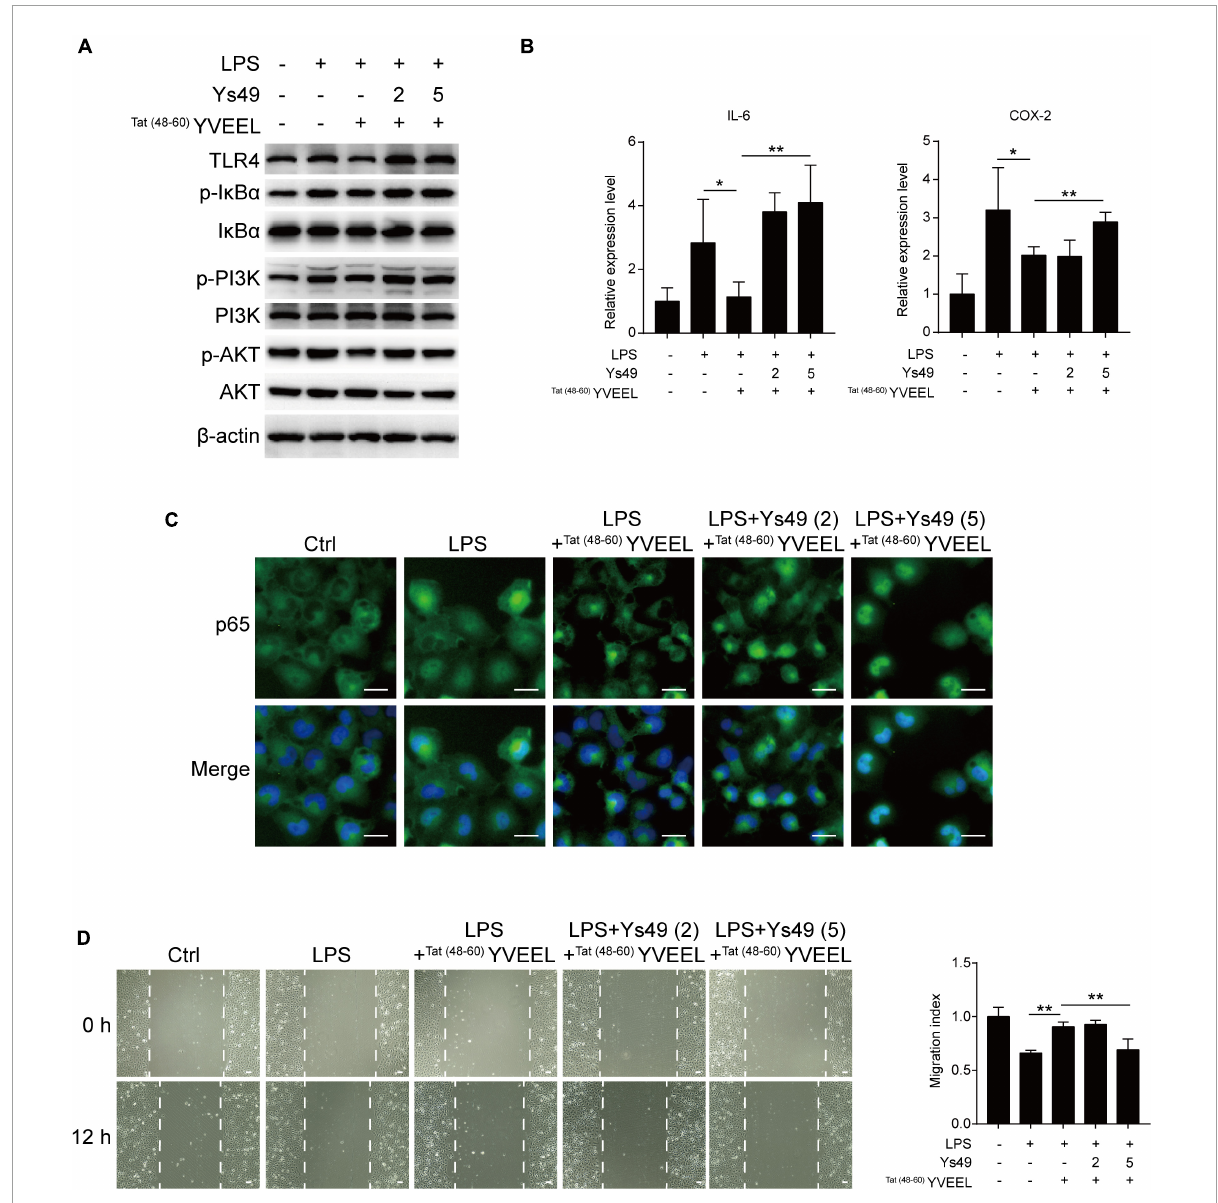
FIGURE4 Tat ( 48 - 60 ) YVEEL attenuates TLR4-mediated signaling and restores cell migration via inhibiting PI3K/AKT pathway. Cells were pretreated with Tat ( 48 - 60 ) YVEEL (40 µ M) and the PI3K/AKT activator Ys49 (2 and 5 µ M) for 1 h, followed by LPS treatment. (A) Western blot analysis showing the TLR4-mediated signaling and the phosphorylation of PI3K and AKT in FHC cells; (B) mRNA expression of IL-6 and COX-2 in FHC cells in each indicated group, * p < 0.05; (C) representative graphs of Control (Ctrl), LPS, LPS + Tat ( 48 - 60 ) YVEEL and LPS + Tat ( 48 - 60 ) YVEEL + Ys49 (2 and 5 µ M) treated FHC cells stained for the p65 subunit of NF- κ B (green) and nuclei (DAPI, blue), at × 400 magnification, bar = 25 µ m; (D) cell migration after induction of mechanical scratch in FHC cells under indicated treatment, at × 200 magnification, bar = 50 µ m, the quantitative analyses of cell migration were shown in the right panel. ** p <